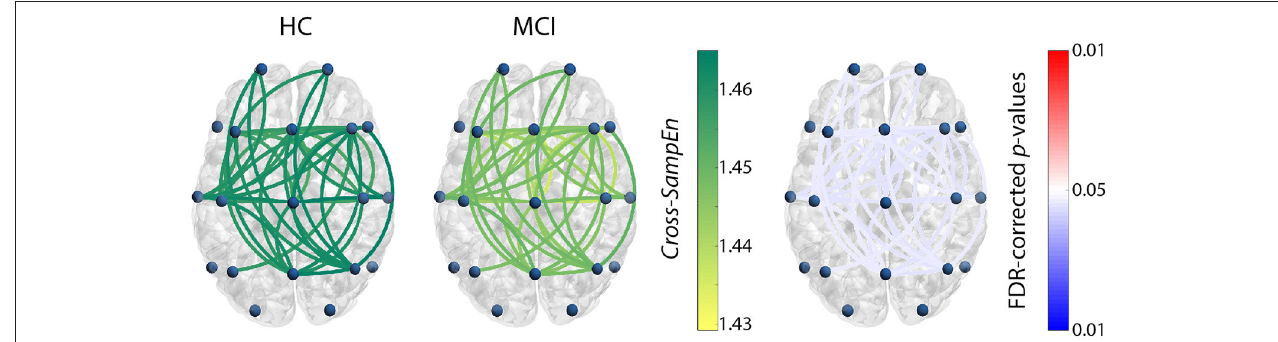
FIGURE 1 | Cross-SampEn results for HC vs. MCI comparison at β 1 band. Left and central columns depict Cross-SampEn values for controls and MCI patients, respectively. Right column displays statistical results, where connections were only displayed when statistically significant differences were obtained (FDR-corrected p -values < 0.05, Mann-Whitney U -test). Red color tones indicate significant Cross-SampEn increases in MCI compared with controls, whereas blue color tones denote significant